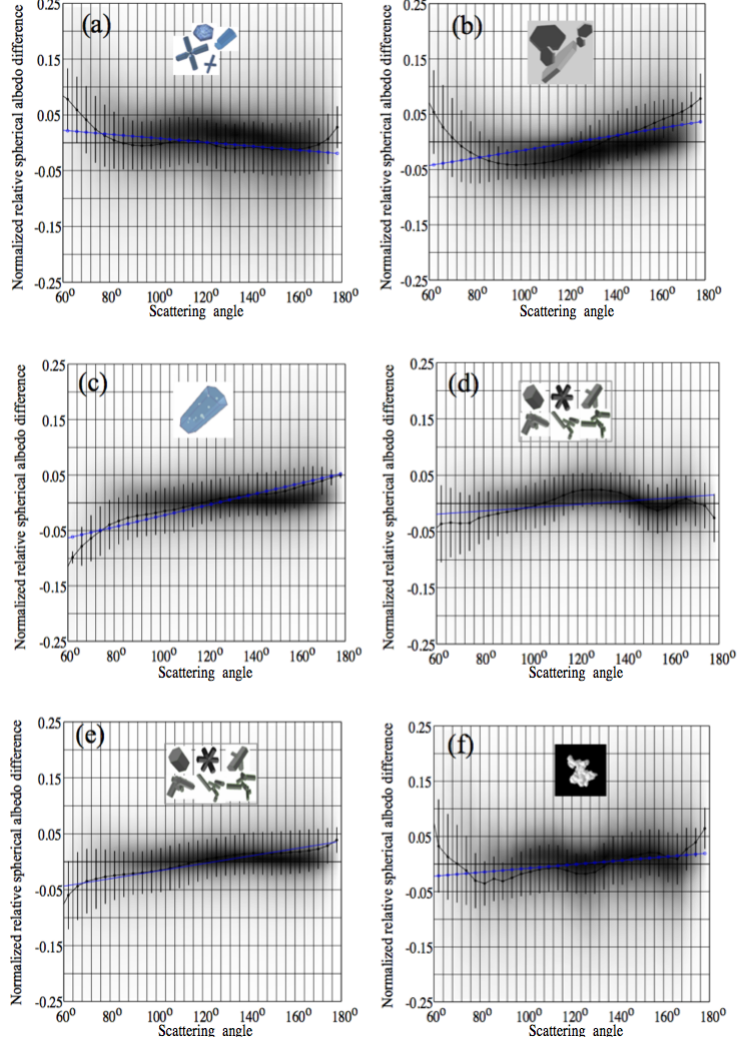
Figure 9. Comparison of the SAD analysis for various ice particle models with (a) D eff = 60µm, GHM model with rough surface; (b) 5- plate_agr, five-plate aggregate model with rough surface; (c) IHM model with smooth surface; (d) Ensemble_ave, ensemble ice particle model with averaged over all distortion value; (e) Ensemble_0.4, ensemble ice particle model by assuming a distortion value of 0.4 with spherical air inclusions; and (f) Voronoi